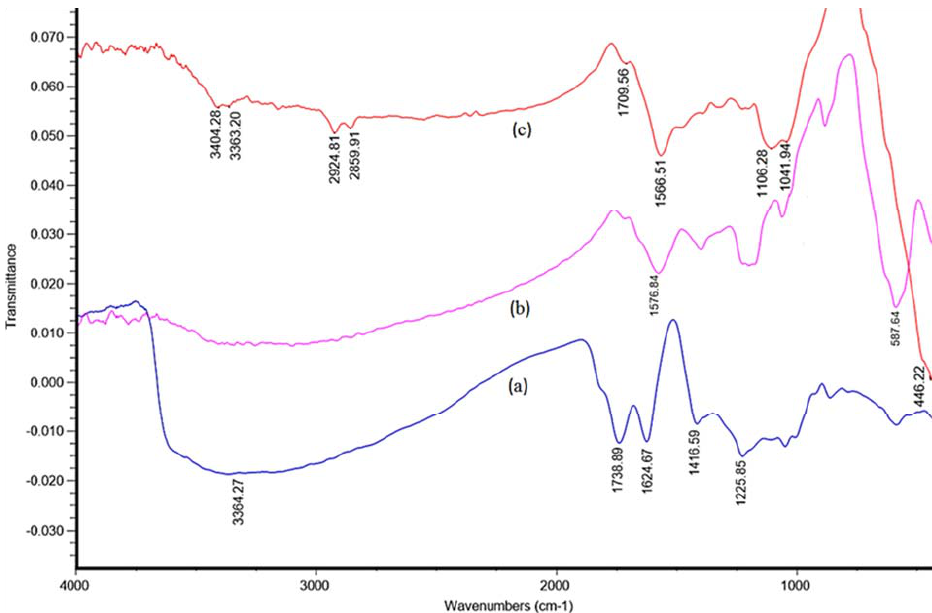
Fig. 1. FT-IR spectra of GO, Fe